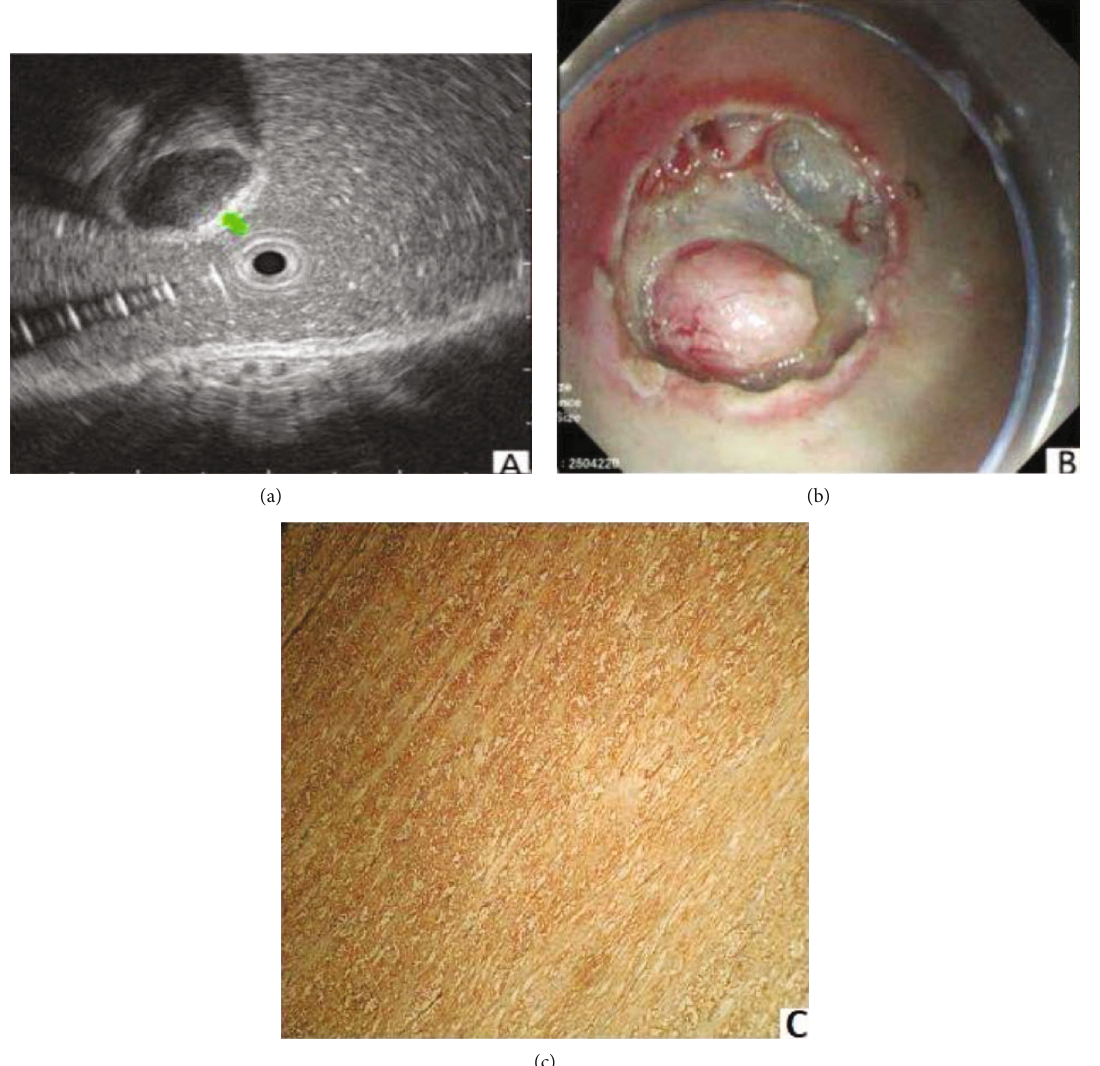
Figure 2: Leiomyoma was shown as a round homogenous hyperechoic tissue (a), the layer of the origin muscularis propria (b) and smooth muscle actin (SMA)(+), CD117(-), and CD34(-)